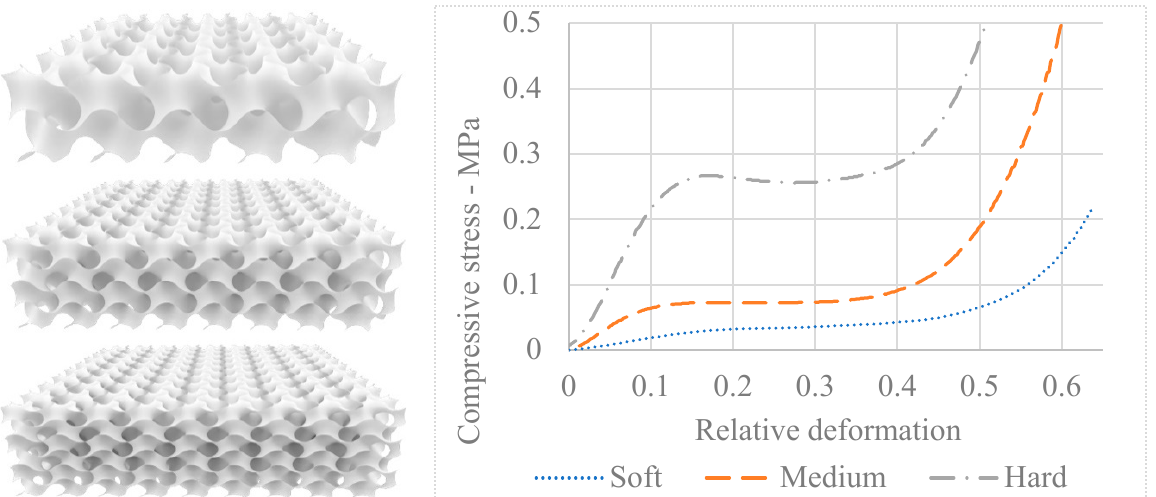
Figure 2. Three-dimensional model of the soft, medium, and hard deformable interface material (top to down—( left )) and corresponding mechanical behavior under compressive stress ( right ).